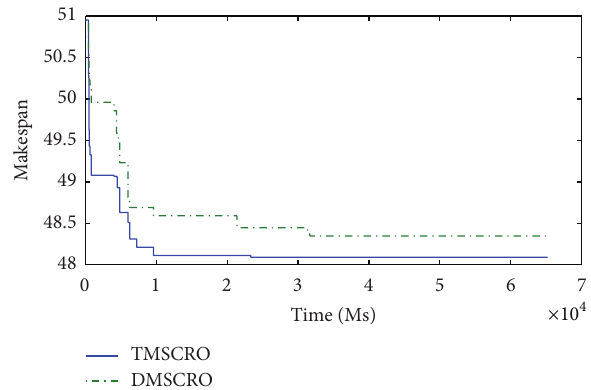
Figure 23: The convergence trace for Gaussian elimination; ccr = 0.2 ; the number of processors is 8.